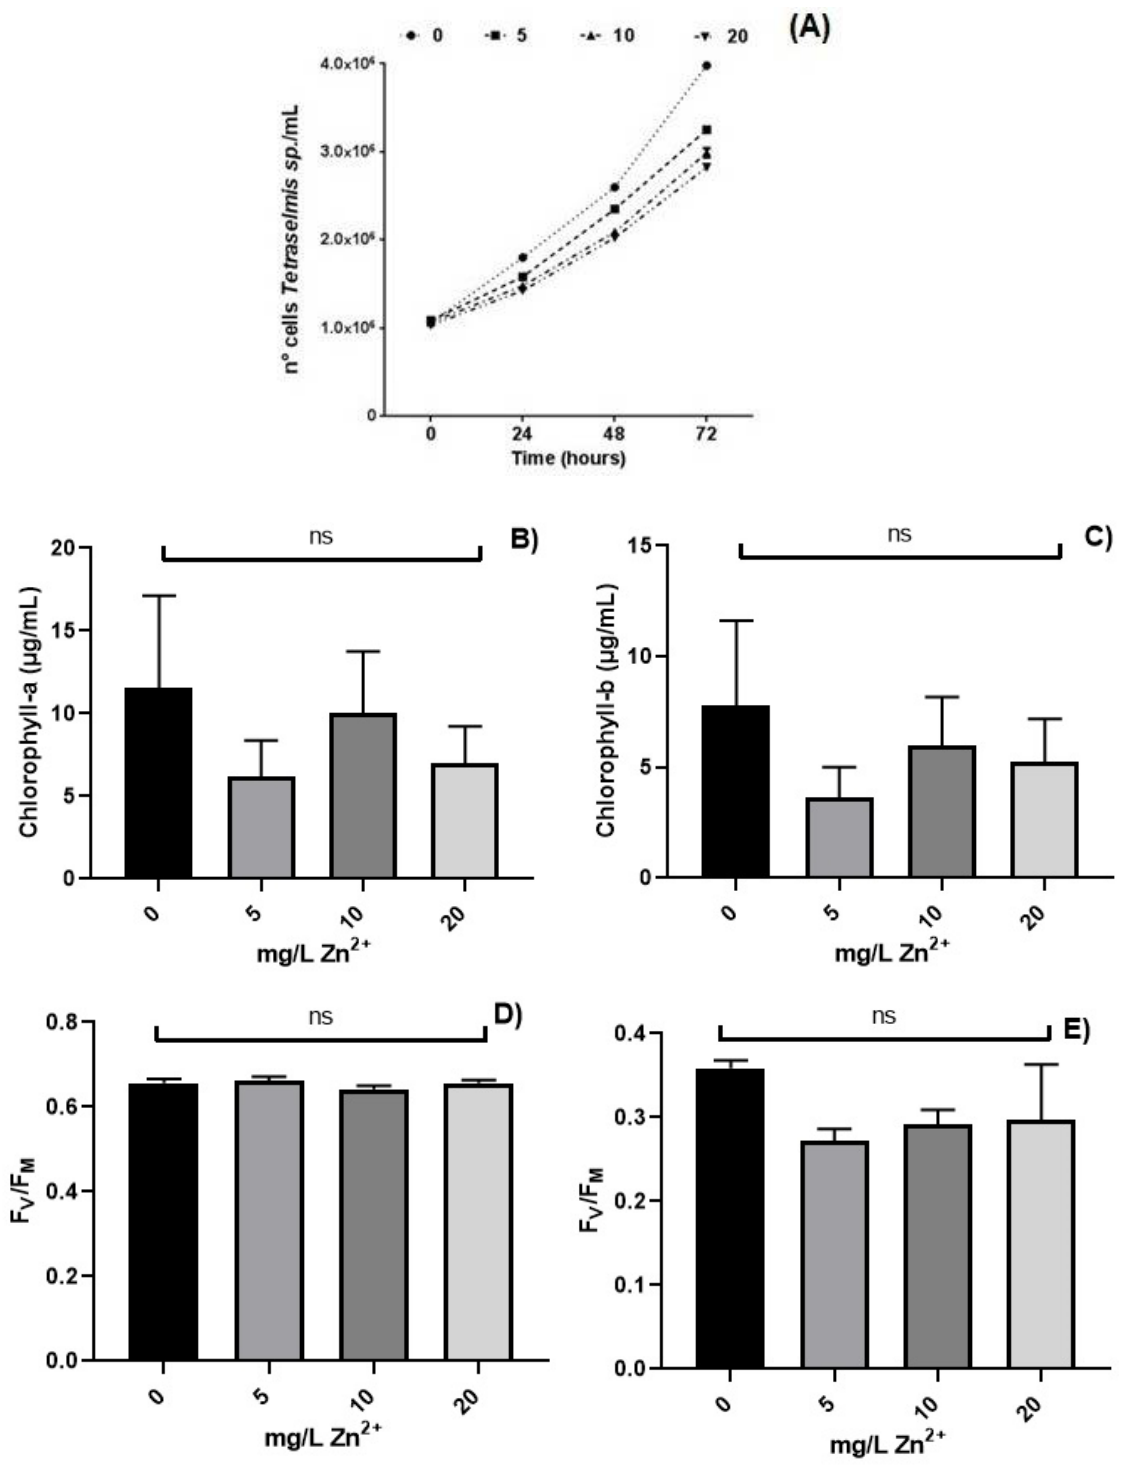
Figure 3. Effect of concentration Zn 2+ (mg/L): ( A ) growth microalgal Tetraselmis marina AC16-MESO at 24, 48, and 72 h. Concentrations of the photosynthetic pigment at 72 h: ( B ) chlorophyll “a”; ( C ) chlorophyll “b”. Maximum quantum yield (F V /F M ) in T. marina AC16-MESO at ( D ) 0 h. ( E ) 72 h of exposure. Bars indicate the standard error (SE); ns indicates not significant, (p > 0.05). 5 vs 0; 10 vs 0; 20 vs 0 (mg/L Zn 2+ ). In Figure 3B,C, the maximum values were found in the negative control (0 mg L –1 Zn 2+ ). An increase or decrease is observed in both chlorophylls “a” and “b” at different